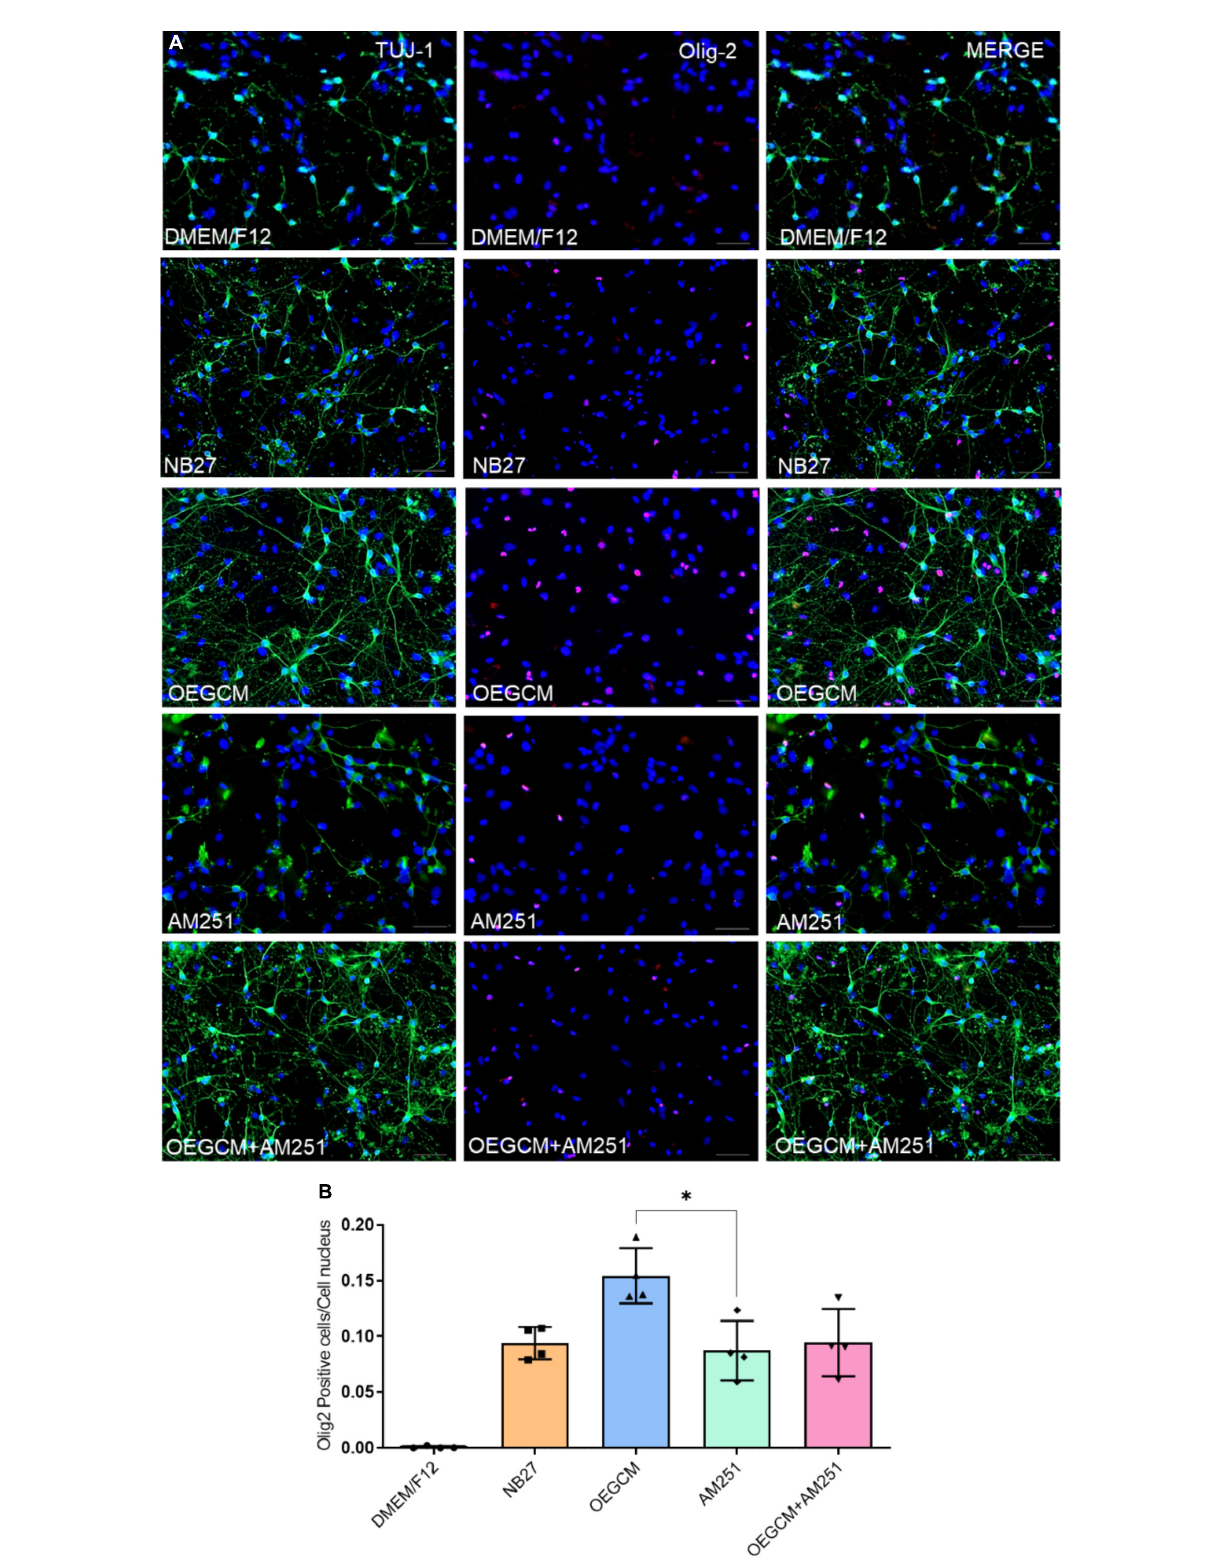
FIGURE3 Addition of AM251 did not reduce the number of Olig2 positive cells increased by OEGCM in hippocampal cells in culture. In panel (A) , neurons labeled in green (TUJ-1), OLs in red (Olig2) and cell nuclei are shown in blue (DAPI); magnification of 20x, scale bar: 50 µ m. In panel (B) , the number of OLs was evaluated counting the number of Olig2 positive cells in each condition (for each experiment, 5 images from different areas for each condition were used for the quantification). Data is presented as mean ± SD, statistical analysis was performed using Kruskal-Wallis and Dunn’s as post hoc test. N = 4 for all experimental conditions, p = 0.1066 for NB27 vs. OEGCM, p > 0.9999 for NB27 vs. AM251, p = 0.1564 for OEGCM vs. OEGCM + AM251, p > 0.9999 for AM251 vs. OEGCM + AM251, p = 0,0375 for OEGCM vs. AM251. * p <